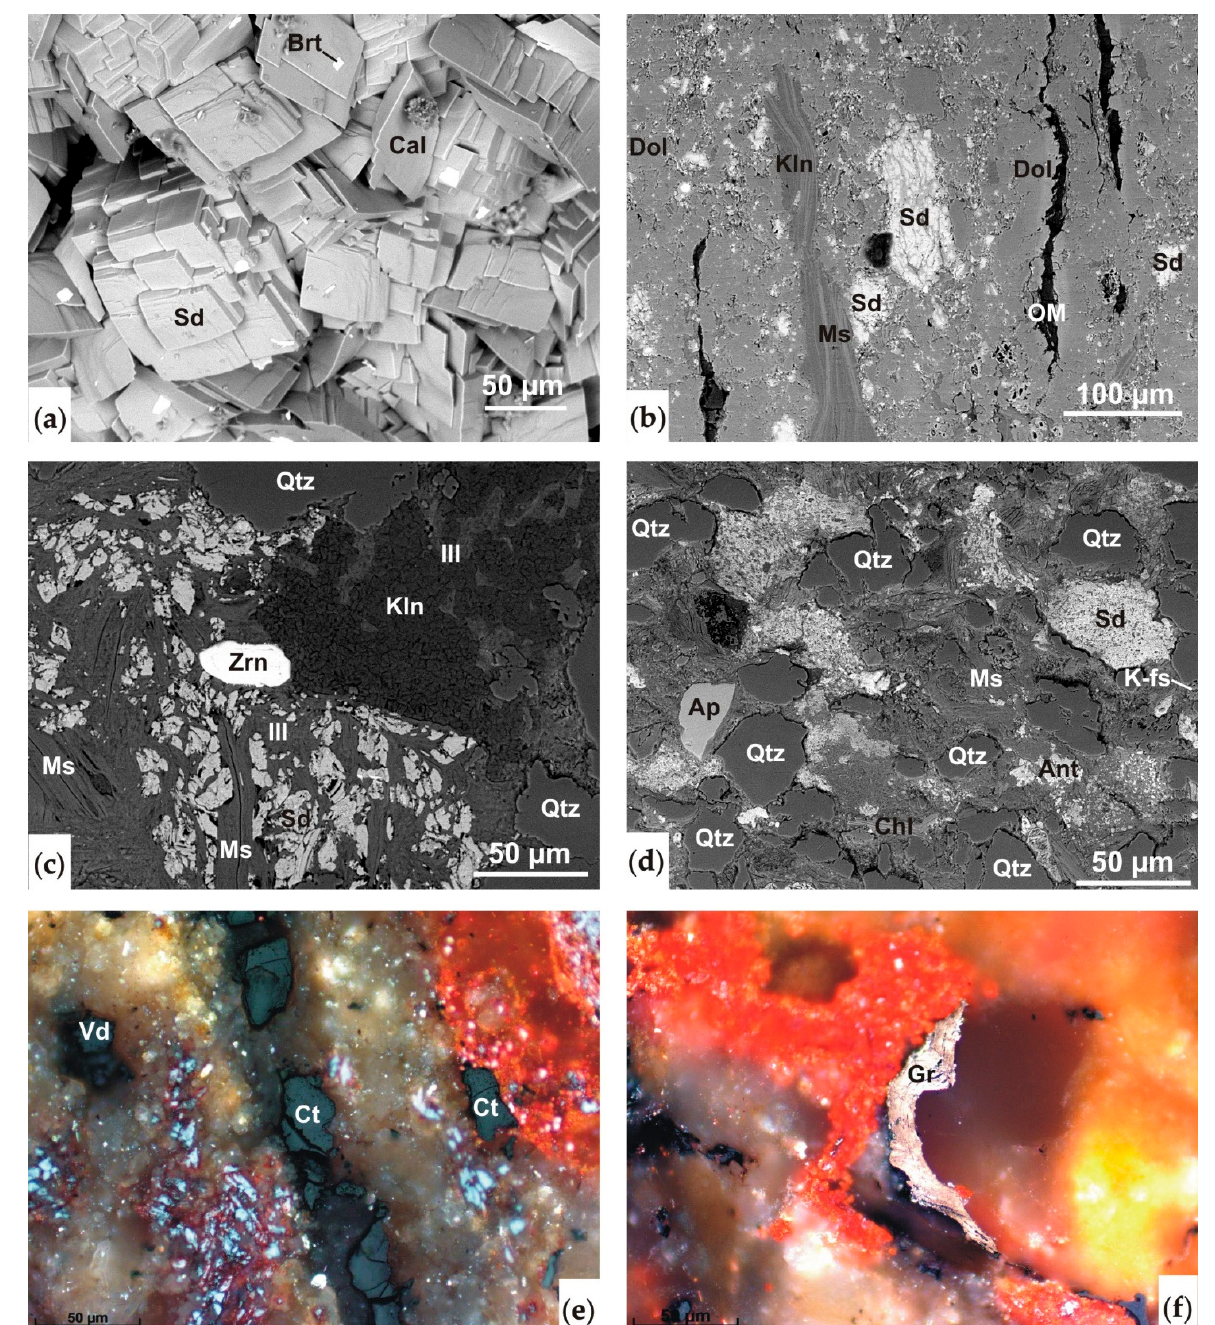
Figure 7. Back ‐ scattered electron BSE ( a – d ) and reflected light optical microscopy RLOM ( e–f ) images of samples collected in the southern part of the Jas ‐ Mos mining area. ( a ) Siderite (Sd) rhombohedra, calcite (Cal) and barite (Brt) occurring in fractures in sample S1; ( b ) carbonates impregnating the gangue rock with dolomite (Dol) forming veins along the organic matter (OM) and kaolinite (Kln) and muscovite (Ms) form interlayers in sample S2; ( c ) quartz (Qtz), muscovite, kaolinite, illite (Ill), siderite and accessory zircon (Zrn) in sample S3; ( d ) secondary hydroxylapatite (Ap), anatase (Ant) among quartz, K ‐ feldspars (K ‐ fs), muscovite, Fe ‐ chlorite (Chl), siderite and clay minerals in sample S5; ( e ) cracked collotelinite (Ct) and vitrodetrinite (Vd) particle in mineral matter in sample S3; ( f ) graphitized carbon in sample S4.